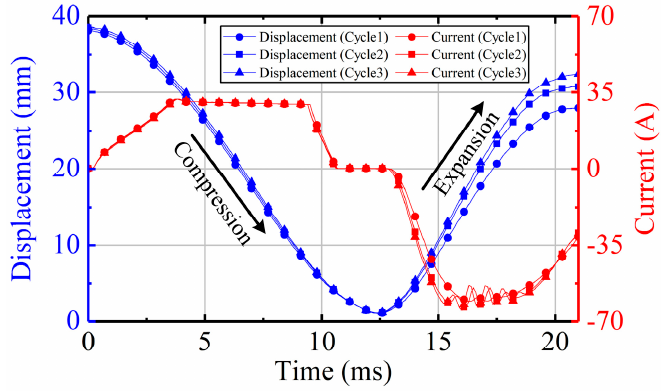
Figure 22. The tested piston motion (fixed generated energy).